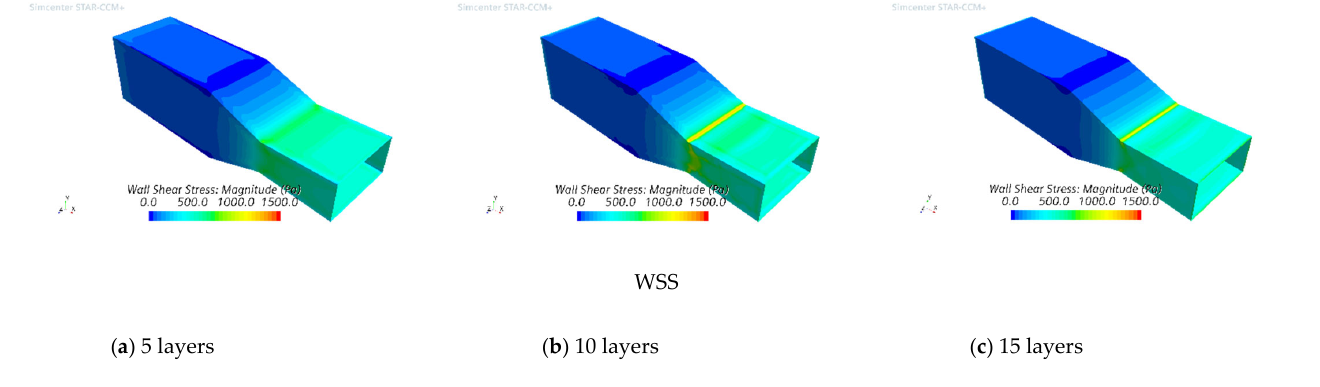
Figure 8. Prism layer sensitivity.